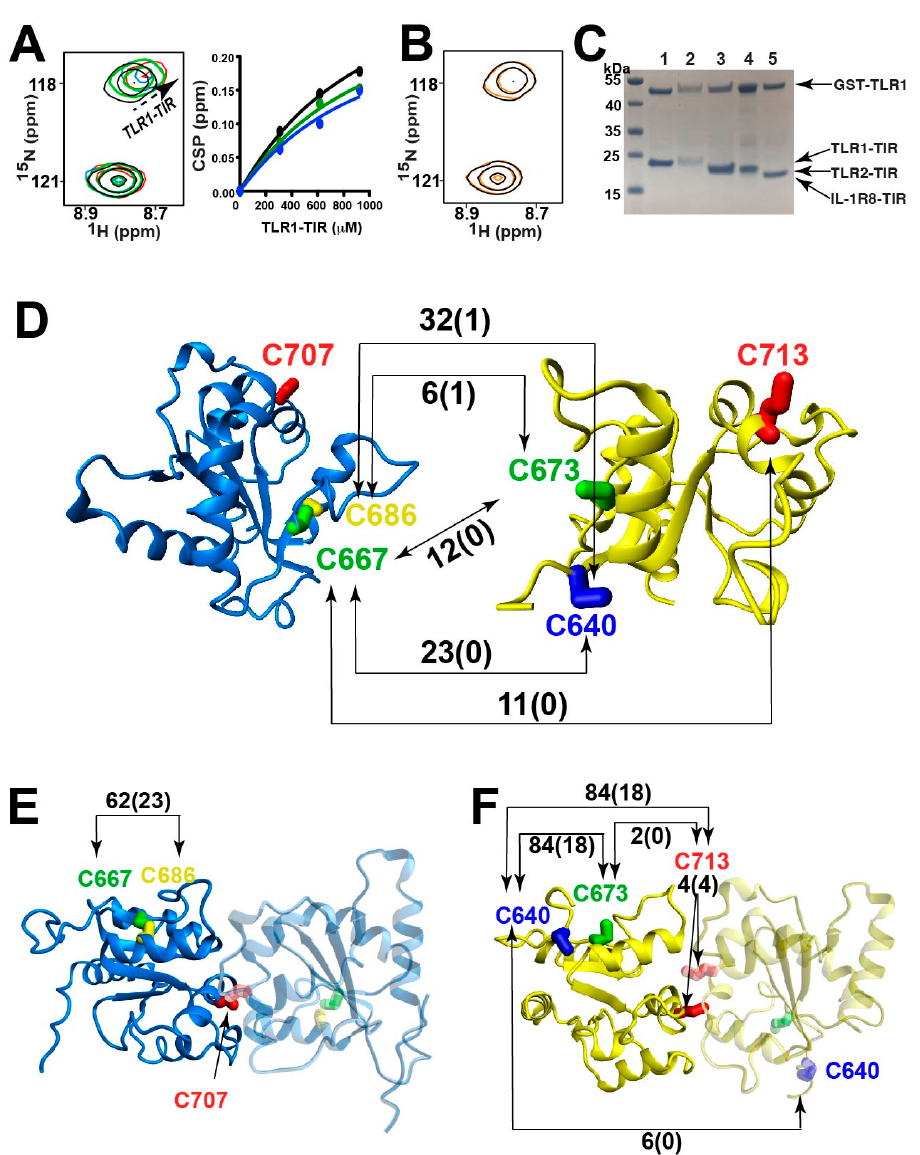
Figure 6. TLR1-TIR and TLR2-TIR heterodimerization. ( A ) 15 N-TLR2-TIR at 308 μ M (black) was ti- trated with TLR1-TIR at 308 μ M (green), 616 μ M (blue), and 924 μ M (red), with the associated bind- ing isotherm derived from several resonances shown and their global fit resulting in 760 ± 230 μ M. ( B ) 15 N-TLR2-TIR at 308 μ M (black) was titrated with full-length tirA at 308 μ M (orange). ( C ) Disul- fide-mediated cross-linking, pull-down experiments using GST-TLR1 were performed with un- tagged TLR1-TIR (lane 1), the TLR1-TIR C707A mutant (lane 2), TLR2-TIR (lane 3), the TLR2-TIR C713A mutant (lane 4), and IL1-R8 TIR (lane 5). ( D ) MS identified disulfide-linked peptides between TLR1-TIR and TLR2-TIR, with the number of peptides identified prior to treatment shown above the arrows and after reduction within parenthesis. ( E ) MS identified disulfide-linked peptides for TLR1-TIR, with the number of peptides shown. ( F ) MS identified disulfide-linked peptides for TLR2-TIR, with the number of peptides shown.